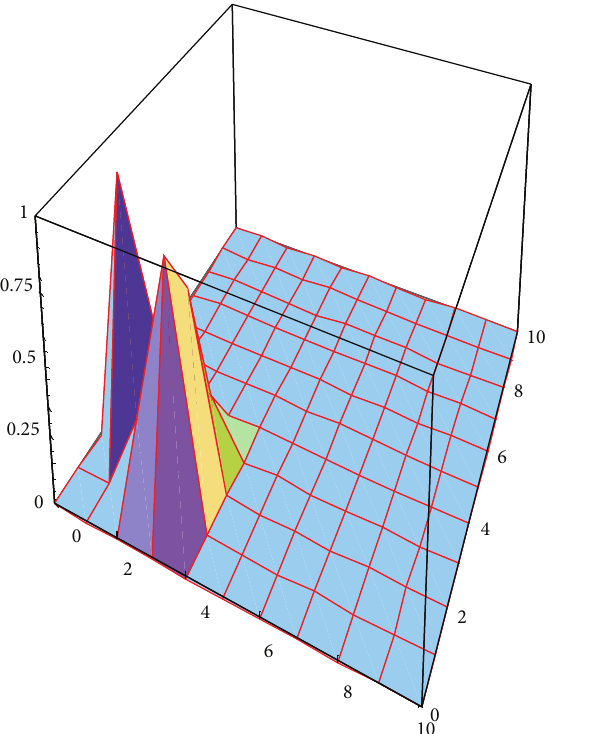
Figure 14: Angelic union of fuzzy relations